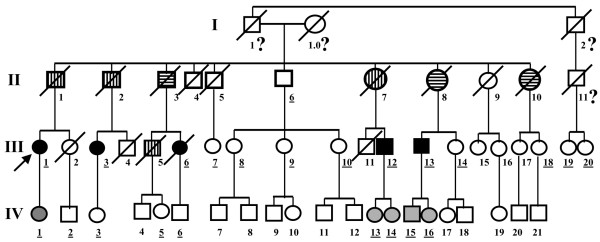
Family pedigree (F01). The proband, III-1, is indicated by an arrow. Members of family with ascertained clinical evidence of Paget's disease of bone (PDB; III-1, III-3, III-6, III-12 and III-13) are represented by black symbols. Subjects strongly suspected to be affected by PDB, as reported by personal history in relatives (II-3, II-8 and II-10), are indicated by horizontal bar symbols. Relatives potentially mutant on the basis of pedigree reconstruction (II-1, II-2, II-7 and III-5) are represented by vertical bar symbols. Grey symbols identify individuals known to have the M404V mutation but whose PDB disease was not expressed; open symbols indicate subjects not exhibiting either the mutation or clinical evidence of PDB. Underlined numbers indicate individuals in whom a genetic test was performed. Question marks identify individuals whose clinical phenotype is not verifiable.